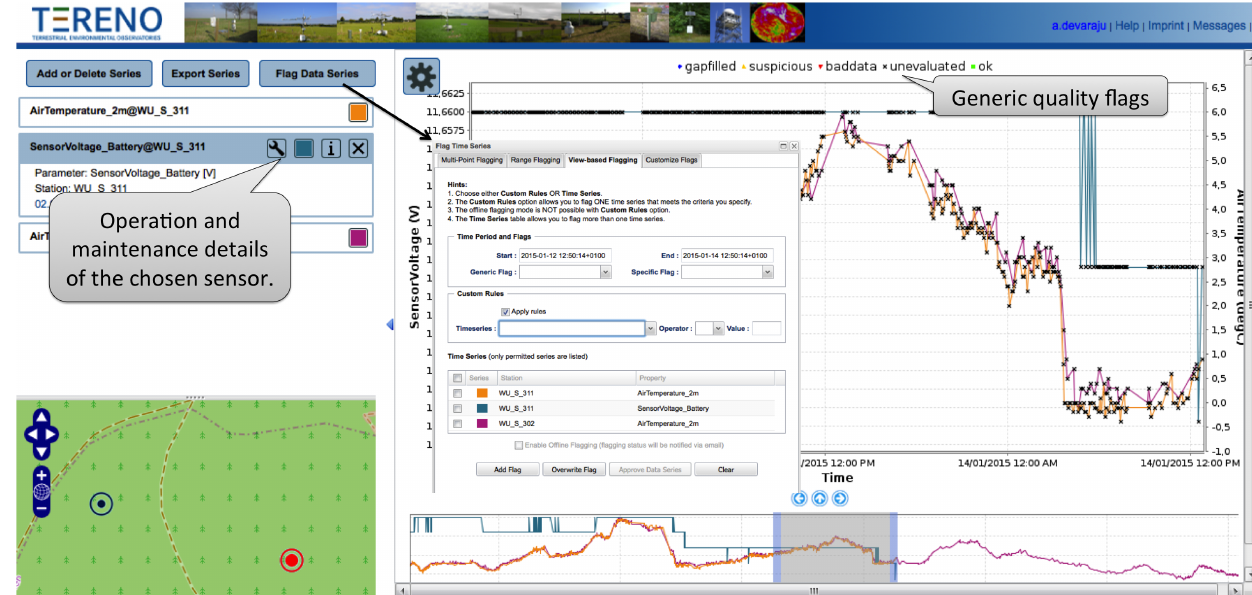
Figure 7. Assess data visually with the INSPECT online flagging tool.